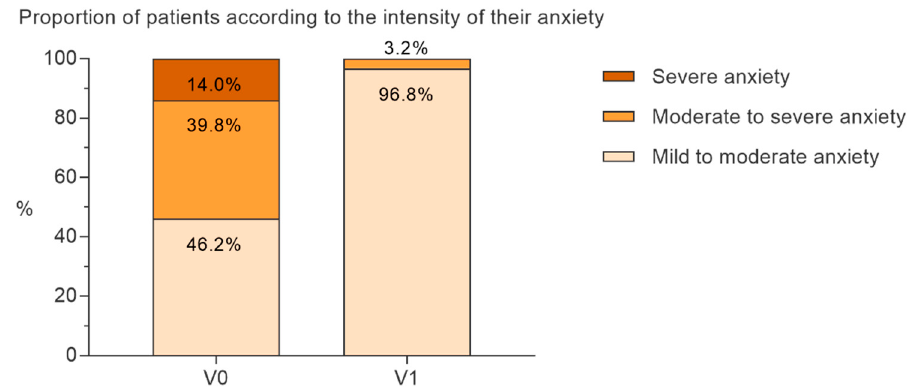
Figure 4. Percentage of patients with severe (Ham-A > 30), moderate (25 ≤ Ham-A ≤ 30) or mild anxiety (Ham-A ≤ 24) at V0 and V1.